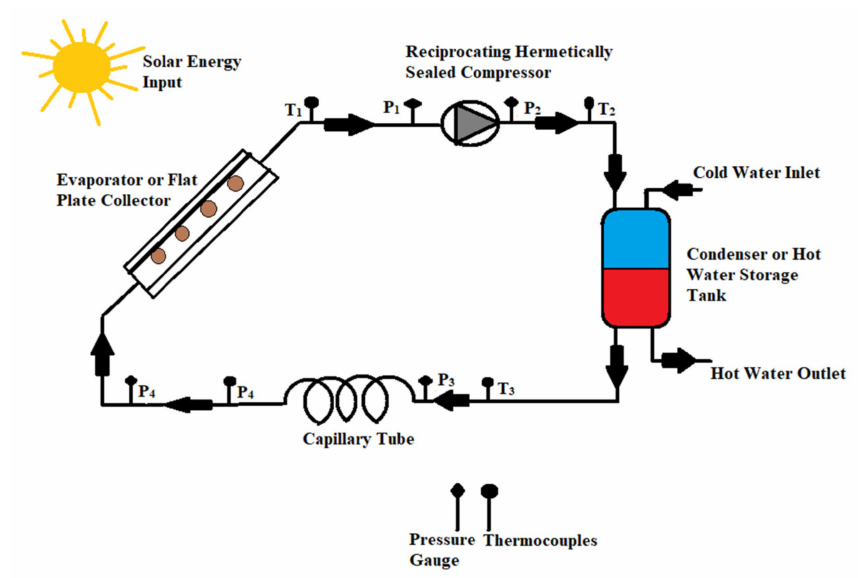
Figure 7. Solar thermal conversion